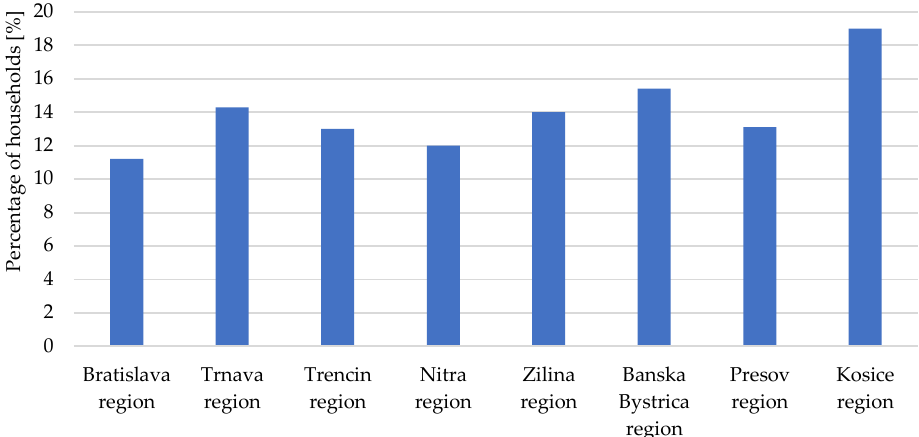
Figure 2. Households at risk of energy poverty according to the LIHC/m 2 indicator in relation to the regions [20].